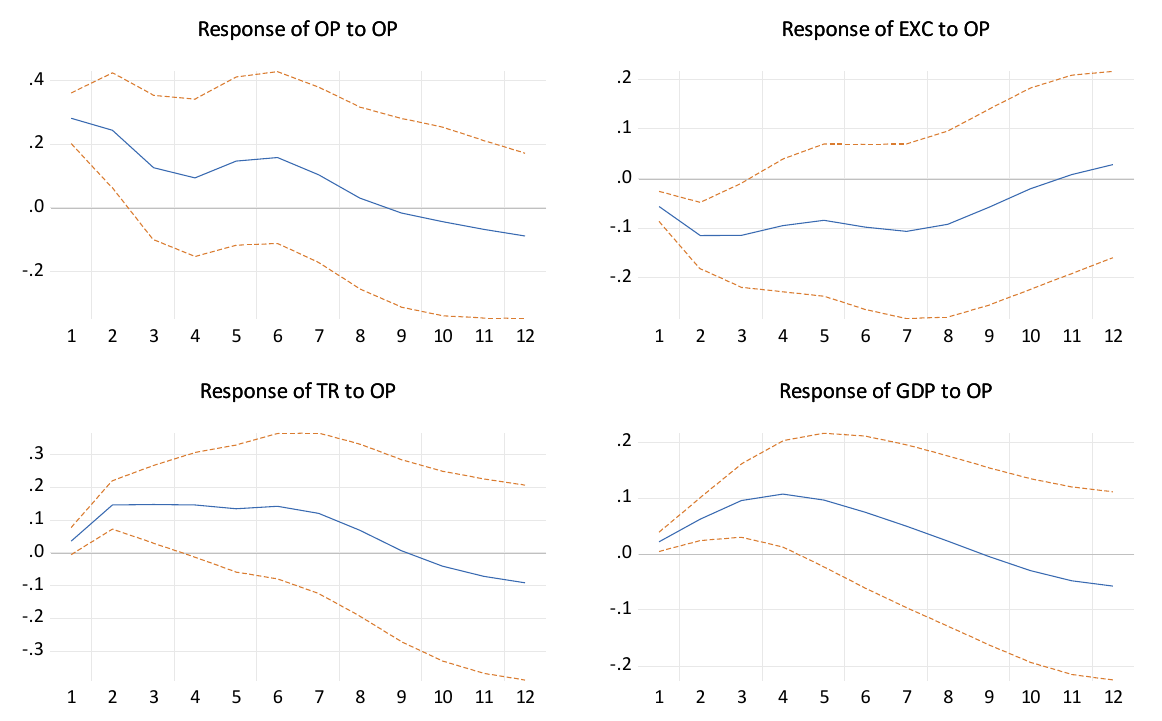
Figure 2. The Results of Impulse-Response Functions. Table 4. Variance Decomposition: Average of 12